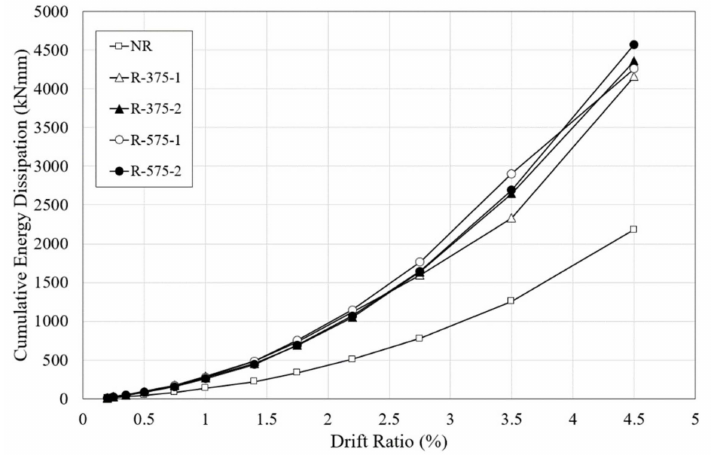
Figure 15. Cumulative energy dissipation capacity according to drift